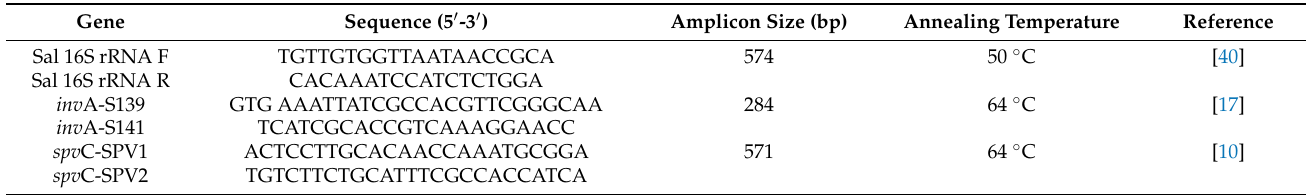
Table 1. List of primers used in this